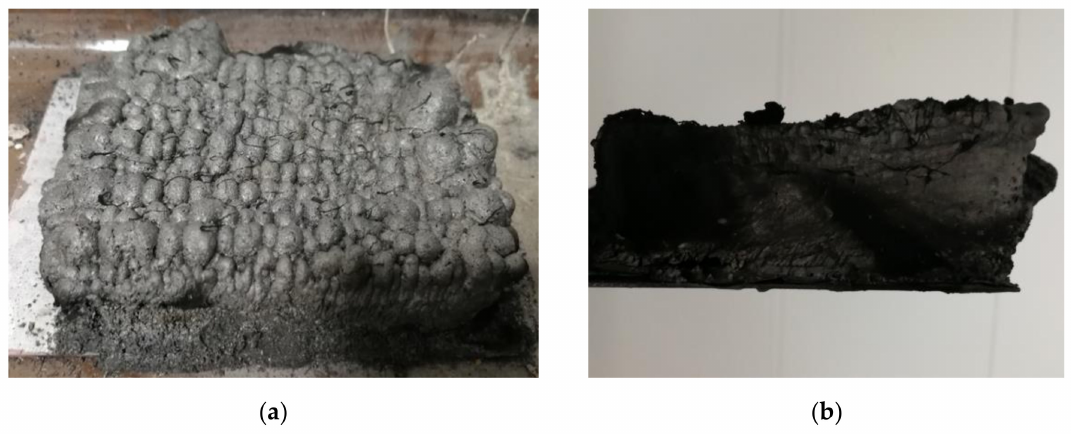
Figure 6. The foamy crust of the samples: ( a ) the foamy crust of Sample 9; ( b ) the foamy crust of Sample